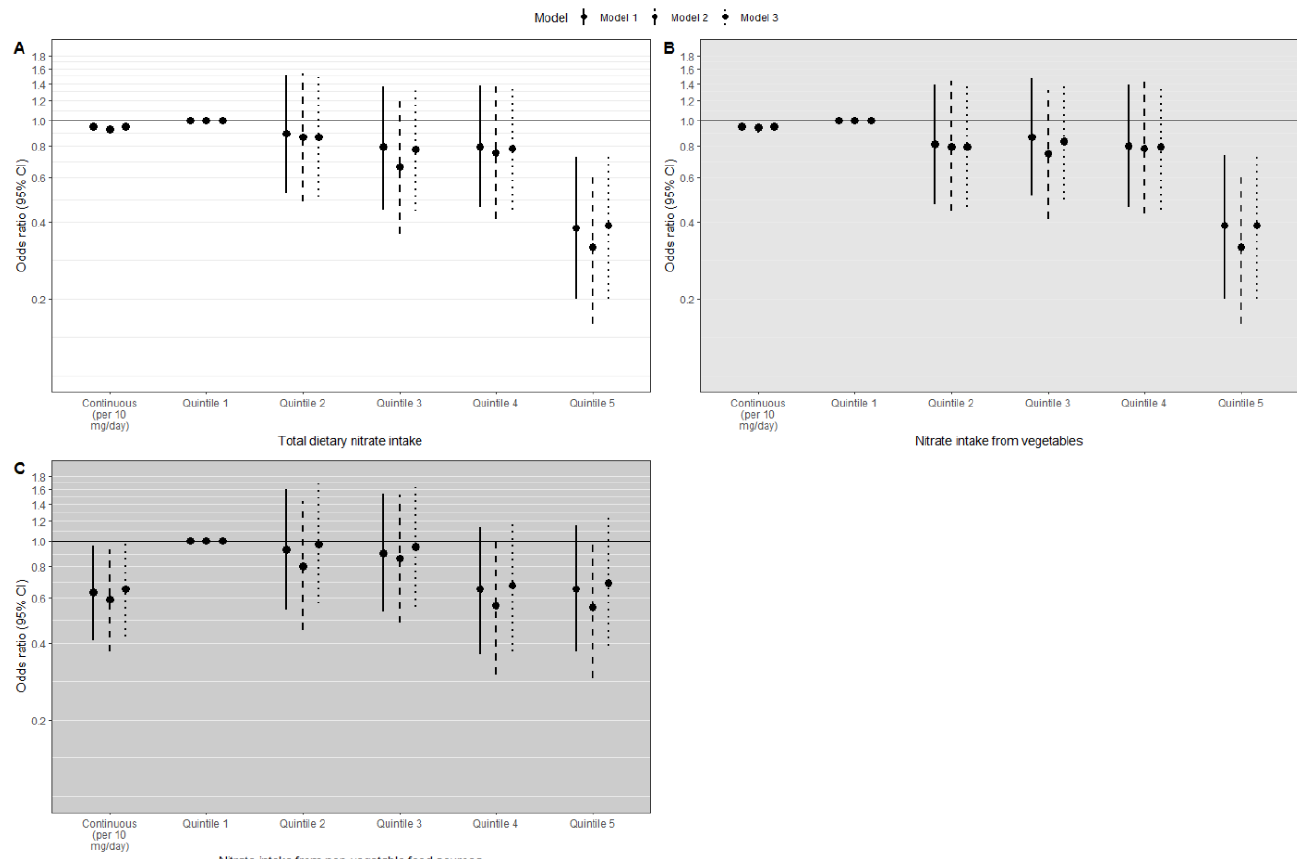
Figure 2. Odds ratios (95% confidence interval (CI)) for open-angle glaucoma by total dietary nitrate intake ( A ), nitrate intake from vegetables ( B ), and nitrate intake from non-vegetable food sources ( C ) (as continuous variables and quintiles) analyzed using conditional logistic regression. Model 1: adjusted for body mass index, total energy intake, diet quality, physical activity, and follow-up time. Model 2: model 1 additionally adjusted for intraocular pressure. Model 3: model 1 additionally adjusted for education level and smoking status.